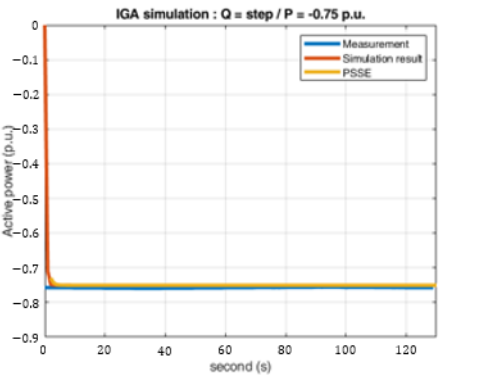
Figure 22. The IGA ( left ) and IPSO ( right ) fitting results .